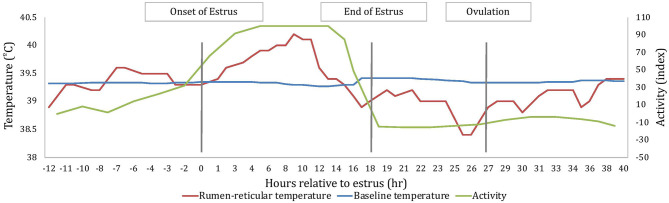
An example depiction, based on one cow, of the variation in rumen-reticular temperature, baseline rumen-reticular temperature, and activity change from the automated activity monitor per hour relative to estrus. Onset and end of estrus is based on the automated activity monitor, while the timing of ovulation is based on ovarian dynamics.